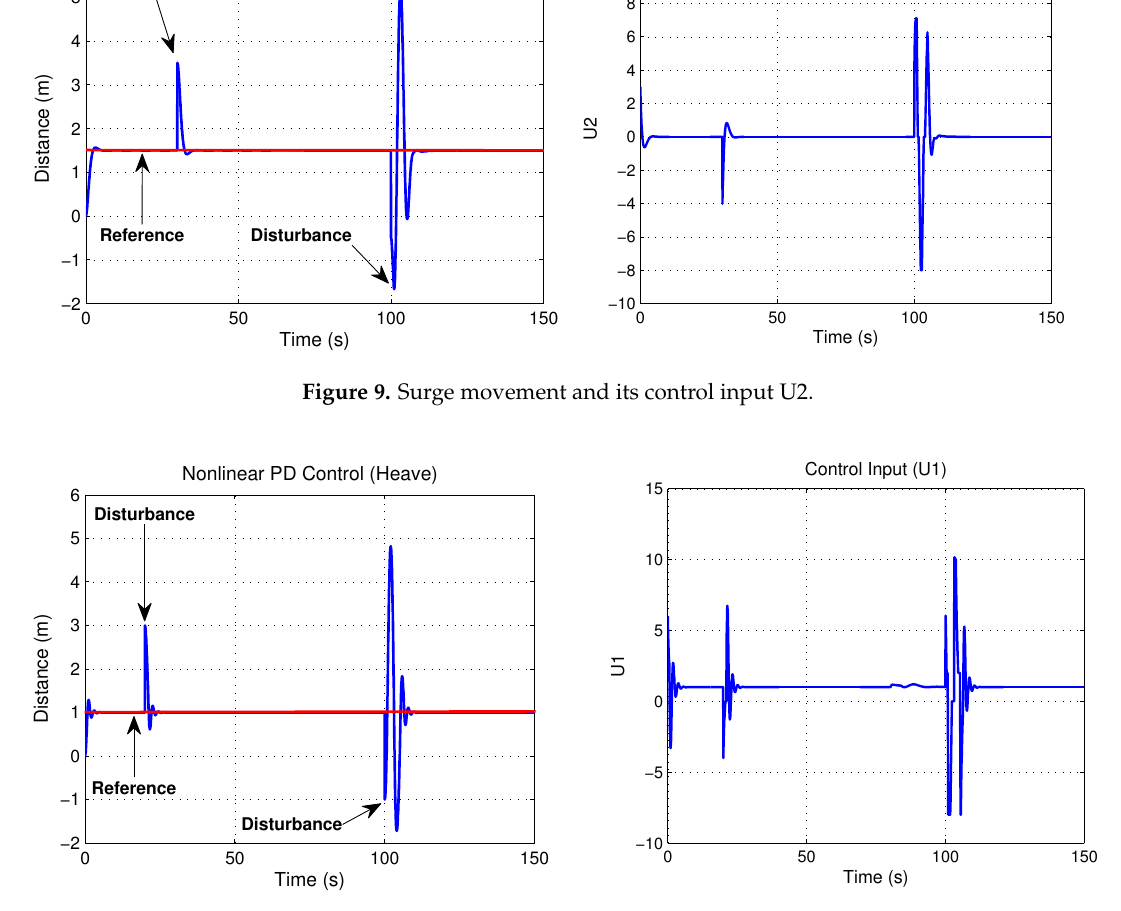
Figure 10. Heave movement and its control input